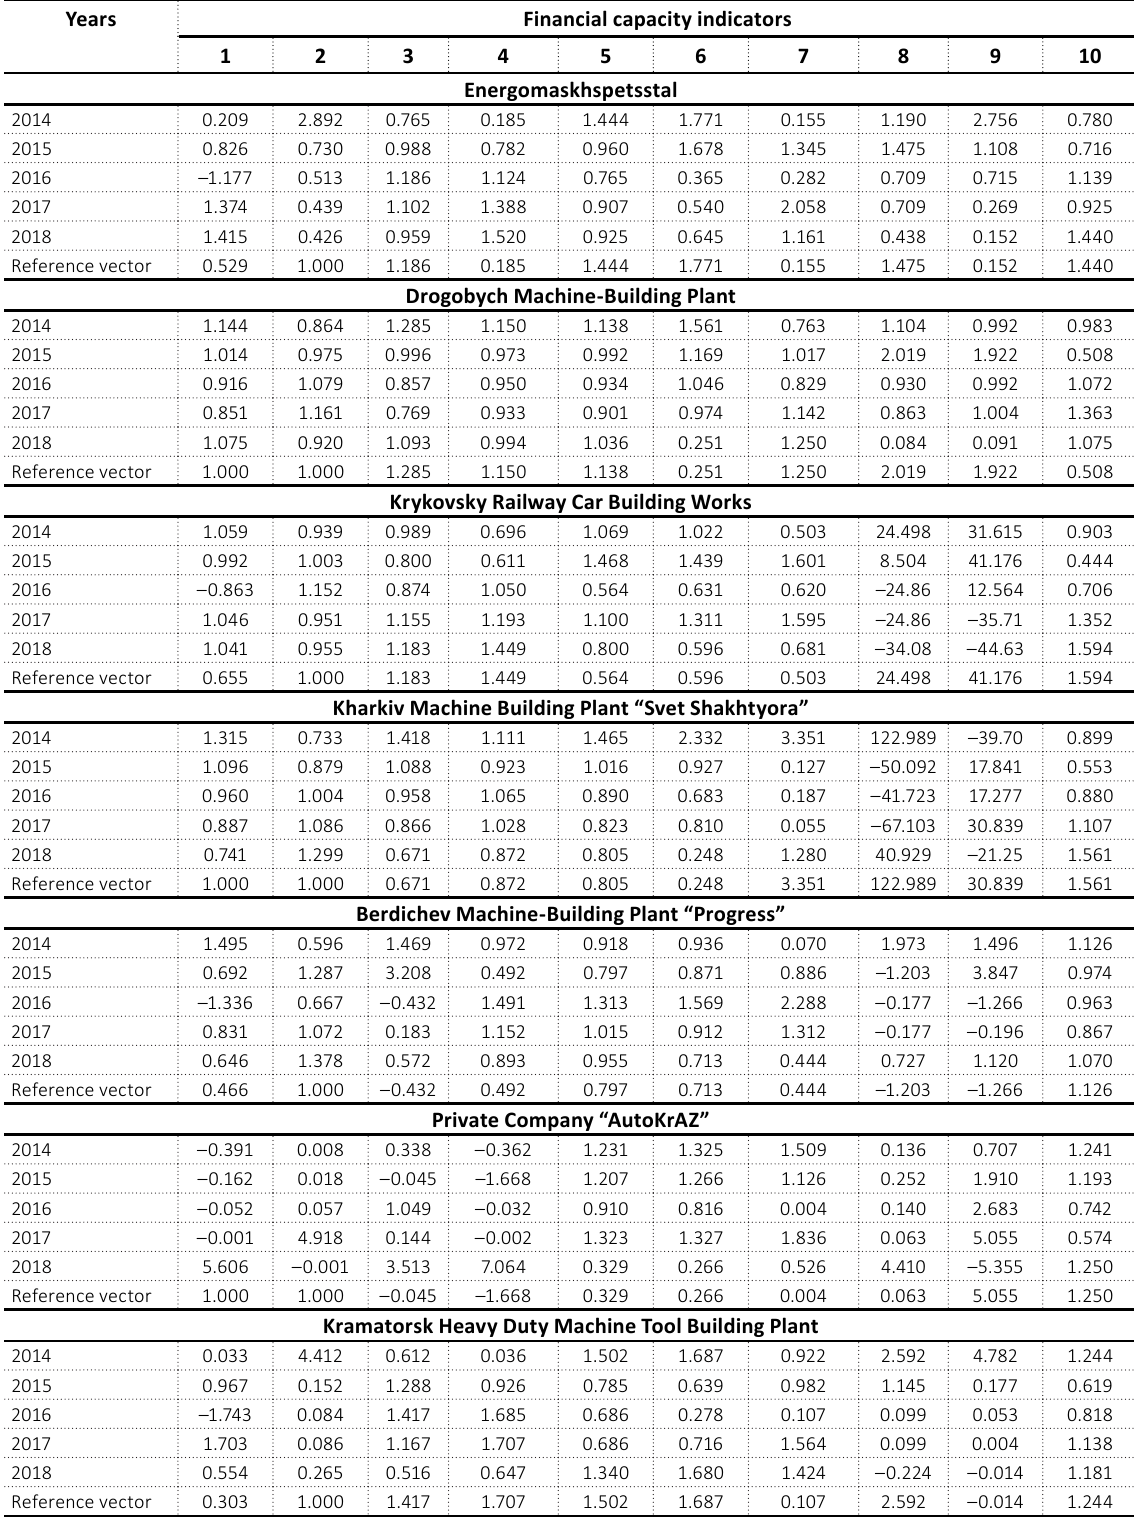
Table A1. Normalized matrix of indicators of enterprises’ financial capacity for 2014–2018 Years